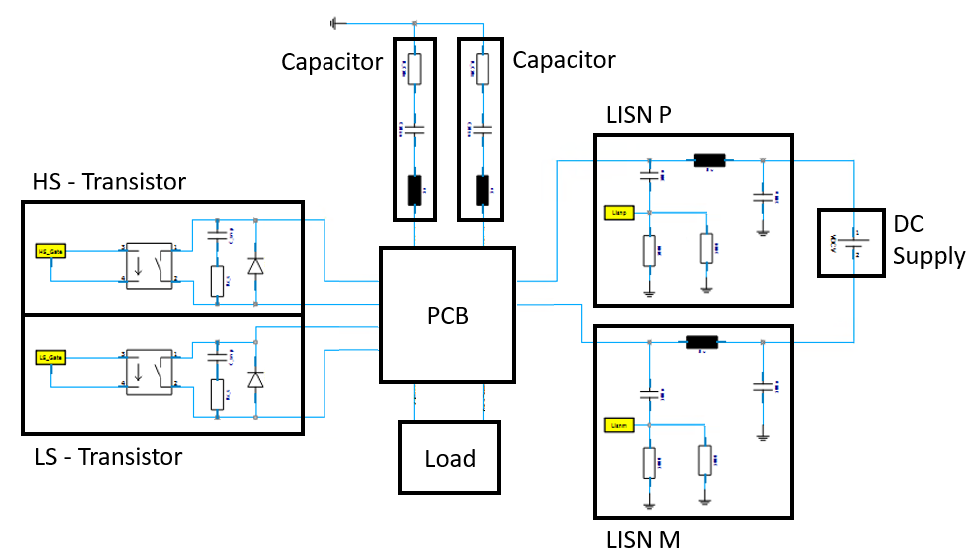
Figure 15. Top-level circuit schematic for the system simulation including the vector-fitted PCB model discussed in Section 3.5 and component models for transistors, capacitors, LISNs, and